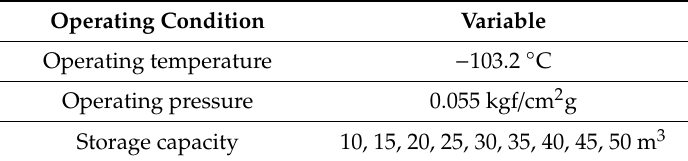
Table 2. Process condition of ethylene storage tank.